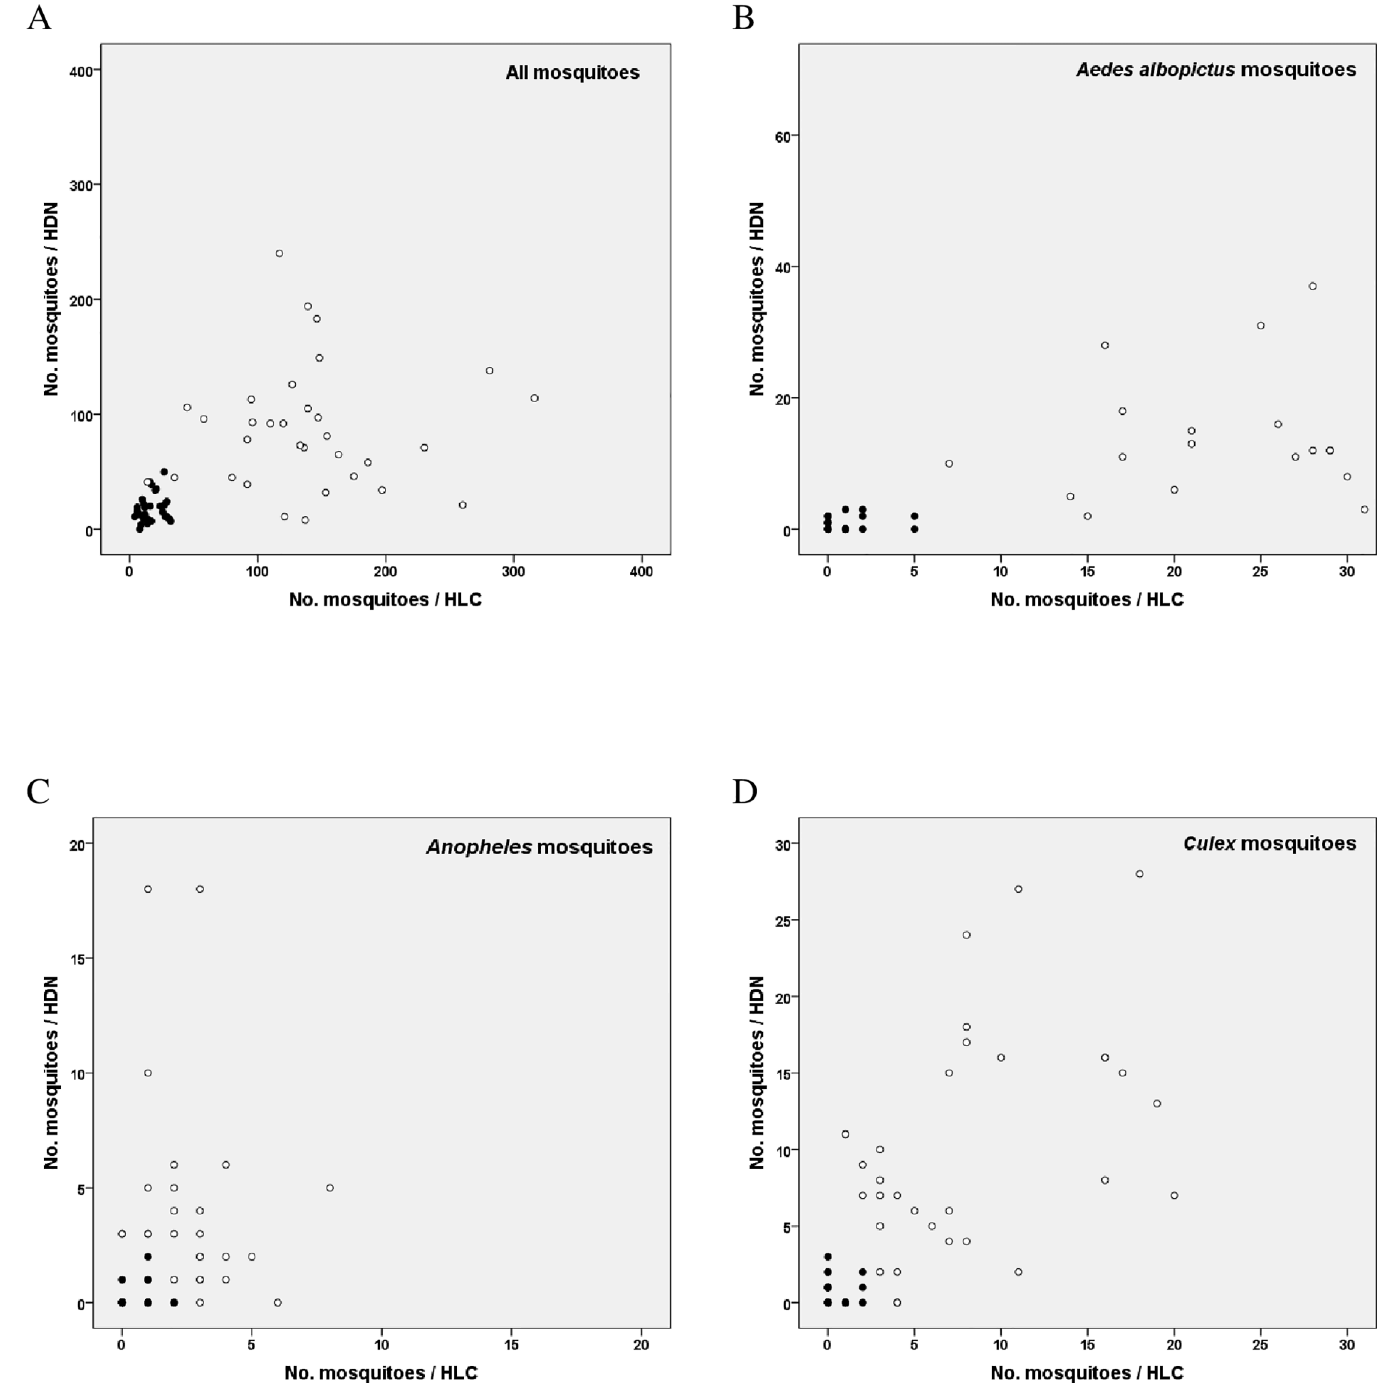
Fig 4. Comparison of the human landing catch and human-baited double net trap (experiment 2) Female mosquitoes collected both day (cid:1) and night ● (A) All mosquito species collected by human landing collections (HLC) (n = 4967) and human baited double net (HDN) collections (n = 3315) (B) All Aedes albopictus mosquitoes collected by human landing collections (HLC) (n = 1163) and human baited double net (HDN) collections (n = 551) (C) All Anopheles mosquito species collected by human landing collections (HLC) (n = 86) and human baited double net (HDN) collections (n = 119) (D) All Culex mosquito species collected by human landing collections (HLC) (n = 268) and human baited double net (HDN) collections (n = 344).